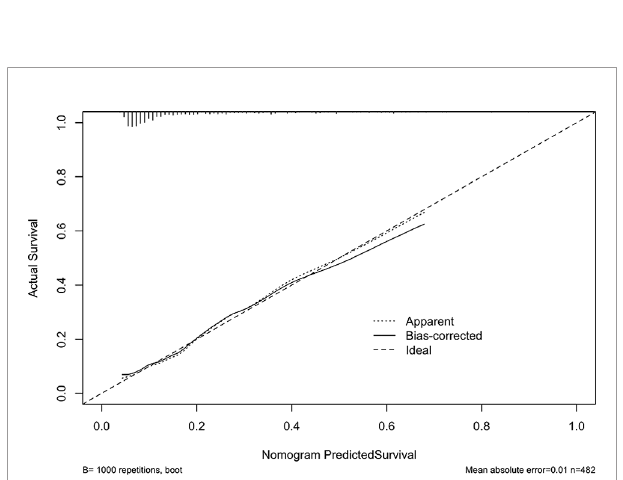
FIGURE 4 | Youden Index.